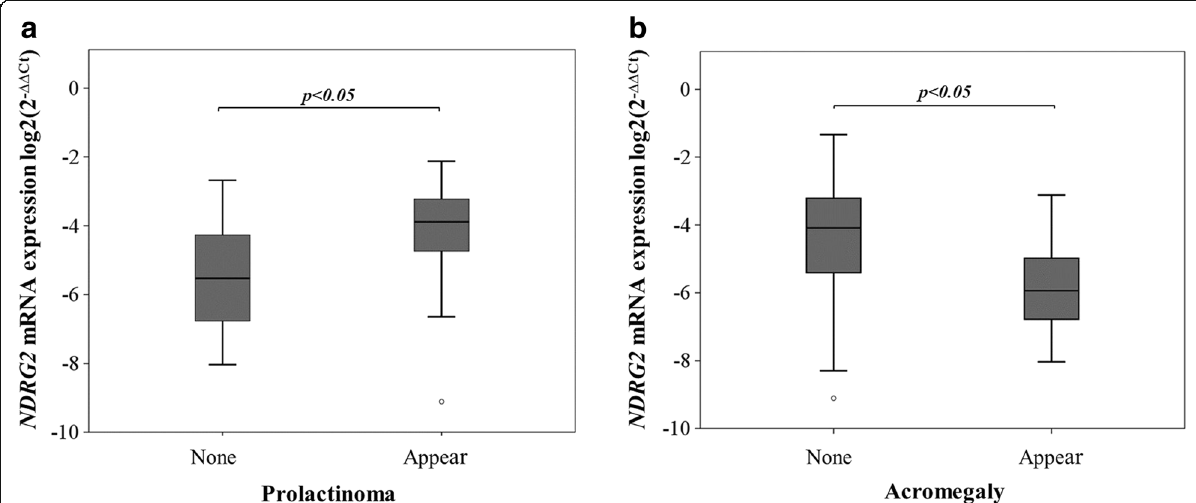
Fig. 2 NDRG2 gene expression associations with diagnoses of prolactinoma and acromegaly. a Box plots of relative NDRG2 expression associated with diagnoses of prolactinoma. b Box plots of relative NDRG2 expression associated with diagnoses of acromegaly. None – no diagnoses of acromegaly. The line inside each box represents the median, the lower and upper edges of the boxes represent the 25th and 75th percentiles, respectively, and upper and lower lines outside the boxes represent minimum and maximum values (error bars). The Mann-Whitney test showed, that the NDRG2 expression level was increased with diagnoses of prolactinoma and decreased with diagnoses of acromegaly ( p < 0.05)